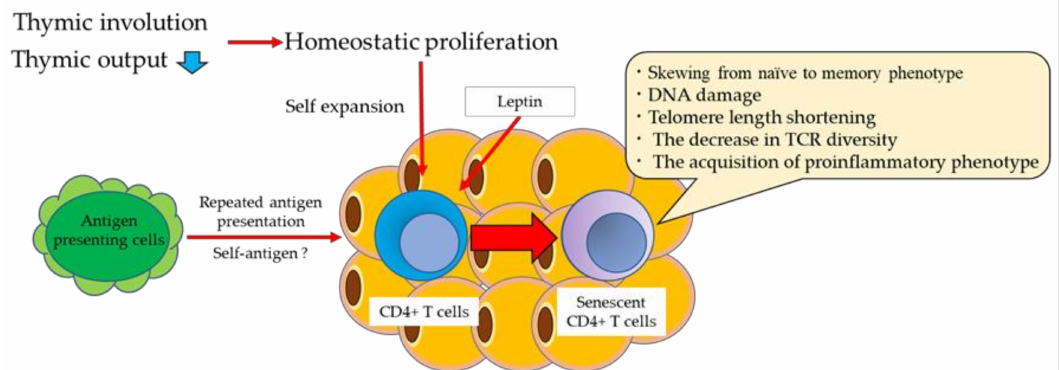
Figure 1. T cell senescence during obesity. Obesity leads to the skewing of the T cell subset from naïve to memory phenotypes, accelerates thymic involution, and restricts TCR diversity. Obesity-induced reduction of thymic output leads to extensive homeostatic proliferation of peripheral T cells, which may contribute to T cell senescence. VAT T cells show a senescent phenotype, including telomere length shortening, restricted TCR diversity, and production of proinflammatory